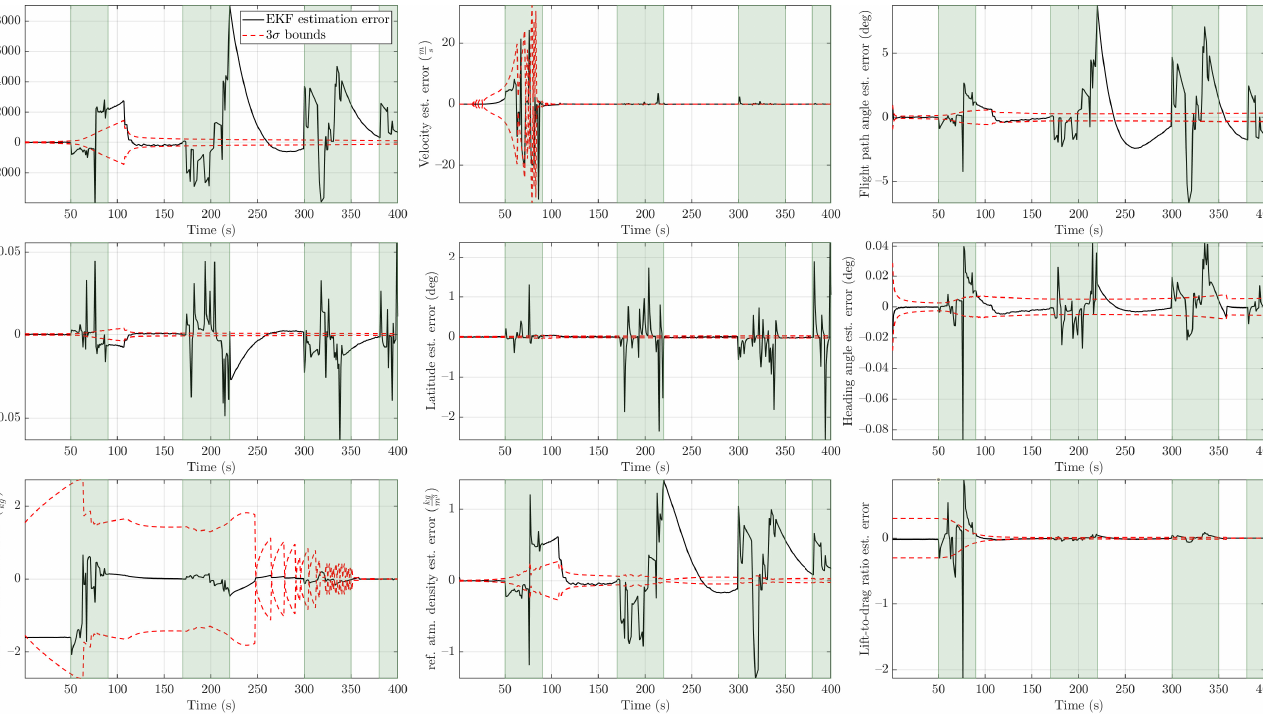
Figure 15. EKF estimation errors with 3 σ bounds for (cid:101) = 0.4 (the time intervals shaded in light green are intervals in which outliers are